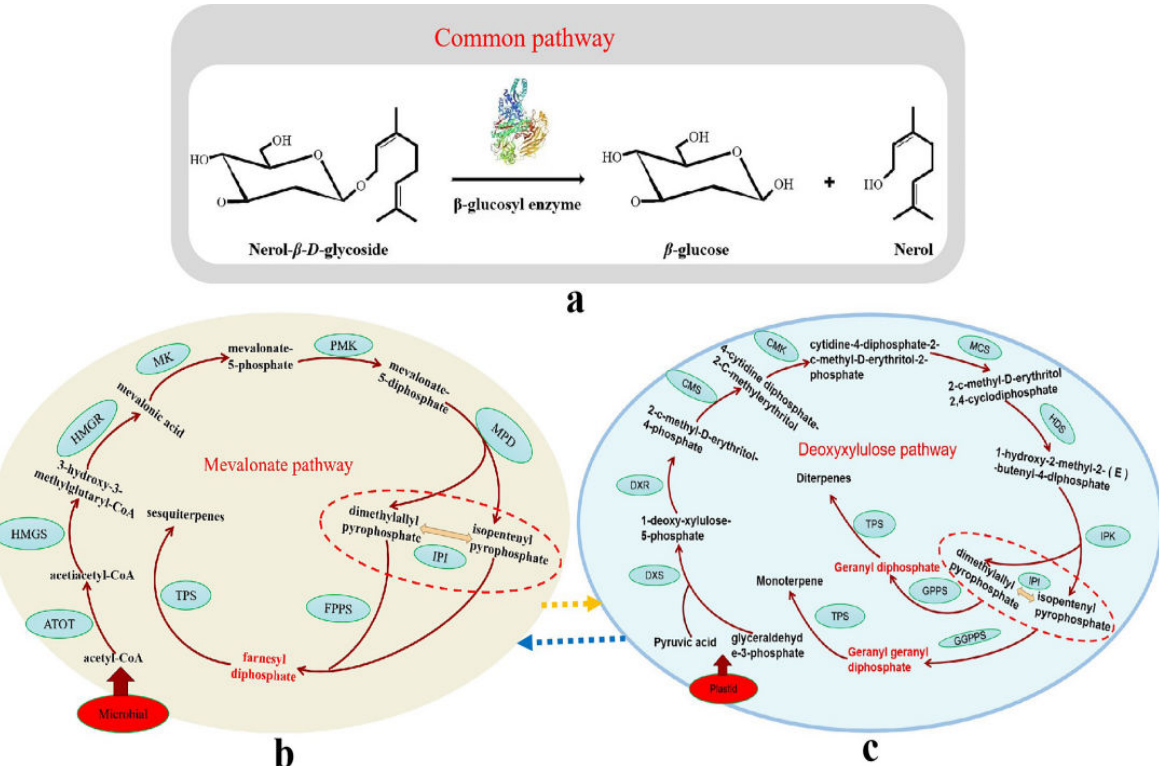
Figure 3. Biosynthesis pathway of terpenes in Chinese Baijiu. ( a ) synthesis path of conjugated ter- penes in Chinese baijiu. ( b ) microbial pathway of terpenes. ( c ) plastid pathway of terpenes. ATOT: Acetoacetyl CoA thiolase, HMGS: Hydroxymethylglutaryl CoA synthase, HMGR: Hydroxy methyl- glutaryl CoA reductase, MK: mevalonate kinase, PMK: Mevalonate dioxyphosphate kinase, MPD: diphosphomevalonate decarboxylase, IPI: isopentenyl diphosphate isomerase, FPPS: Farnesyl phosphate synthase, TPS: terpene synthase, DXS: Deoxyxylulose phosphate synthase, DXR: Deox- yxylulose phosphate reducing isomerase, CMS: Cytidine diphosphate methylerythritol synthase,